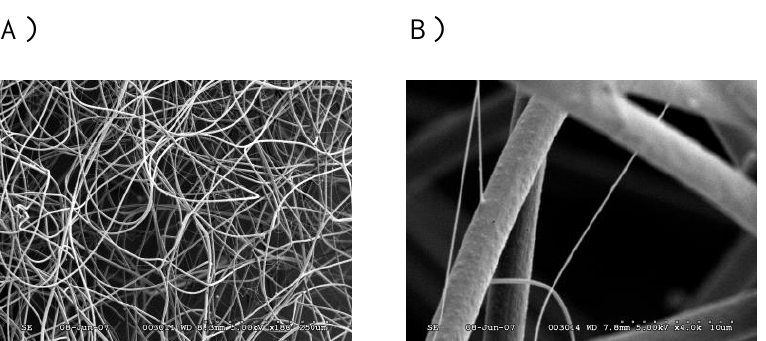
Figure 1. General workflow for isolation of the tubuliform gland, egg sac, and dope (liquid removed from the tubuliform glands), followed by analysis of the tryptic peptides by MS/MS analysis.